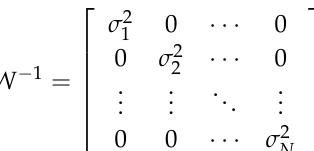
Figure 13. The VPL of a single precision approach under different σ vig